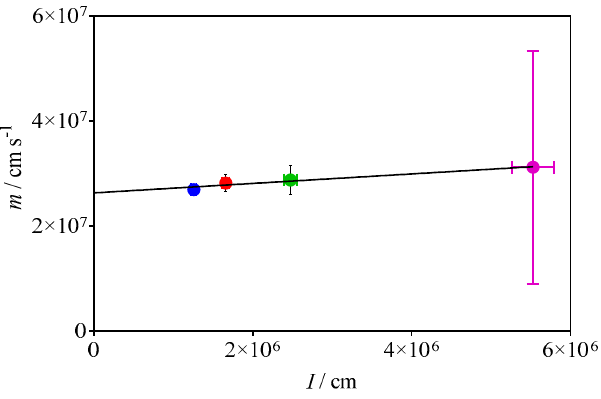
Figure 4. Plot of slope m as a function of I from the linear regressions obtained in Figure 3c . Now, using the above retrieved absorption cross-section for C 2 H 5 O 2 at 7596 cm − 1 of Figure 4 a value for k 1 ,obs = (1.3 ± 0.3) × 10 − 13 cm 3 molecule − 1 s − 1 , in good agreement